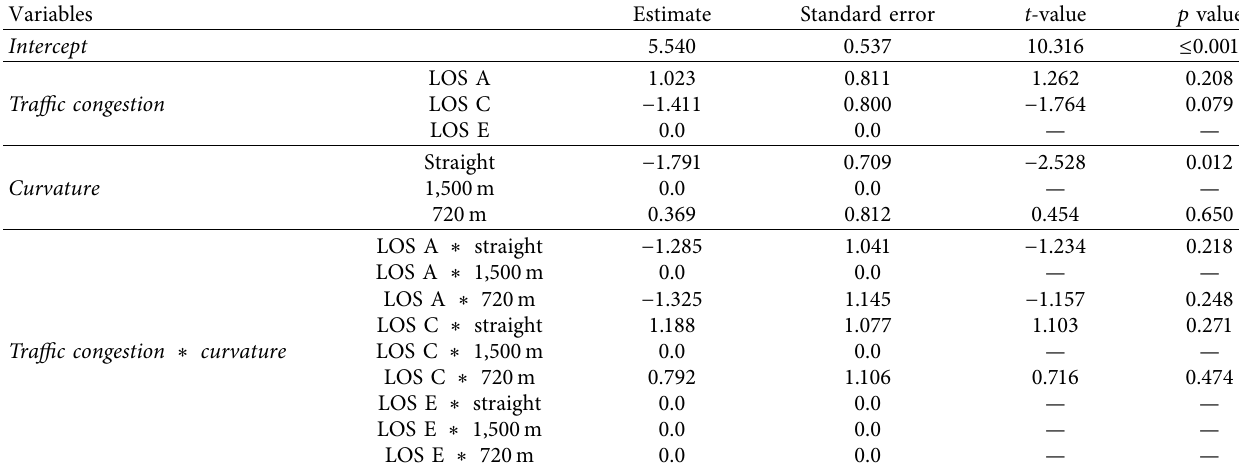
Table 8: Estimated stabilization time from LMM by LOS and curvature.